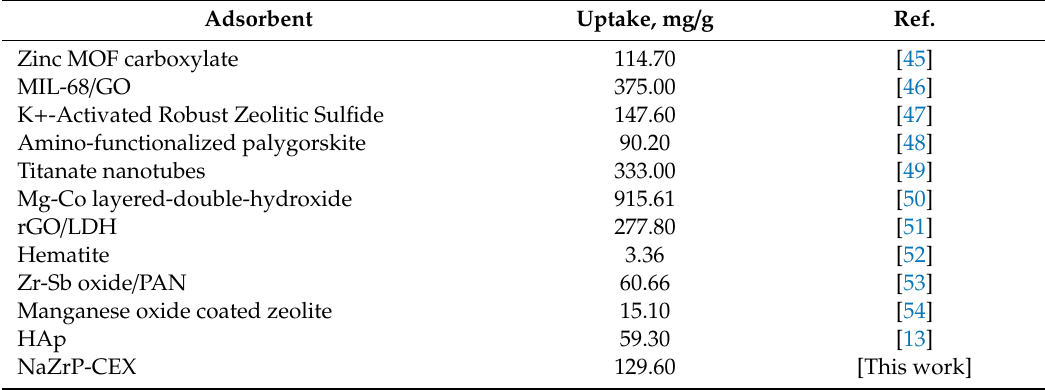
Table 2. Comparison of the adsorption capacities of U(VI) ions onto various inorganic absorbents. Adsorbent Uptake, mg / g Ref.